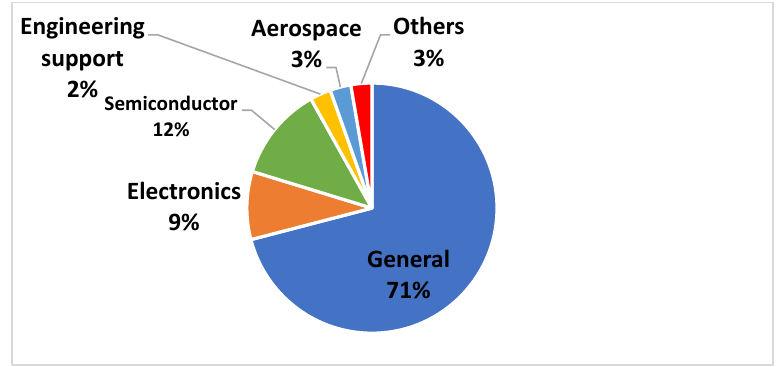
Figure 8. Research interest according to the industrial sector .